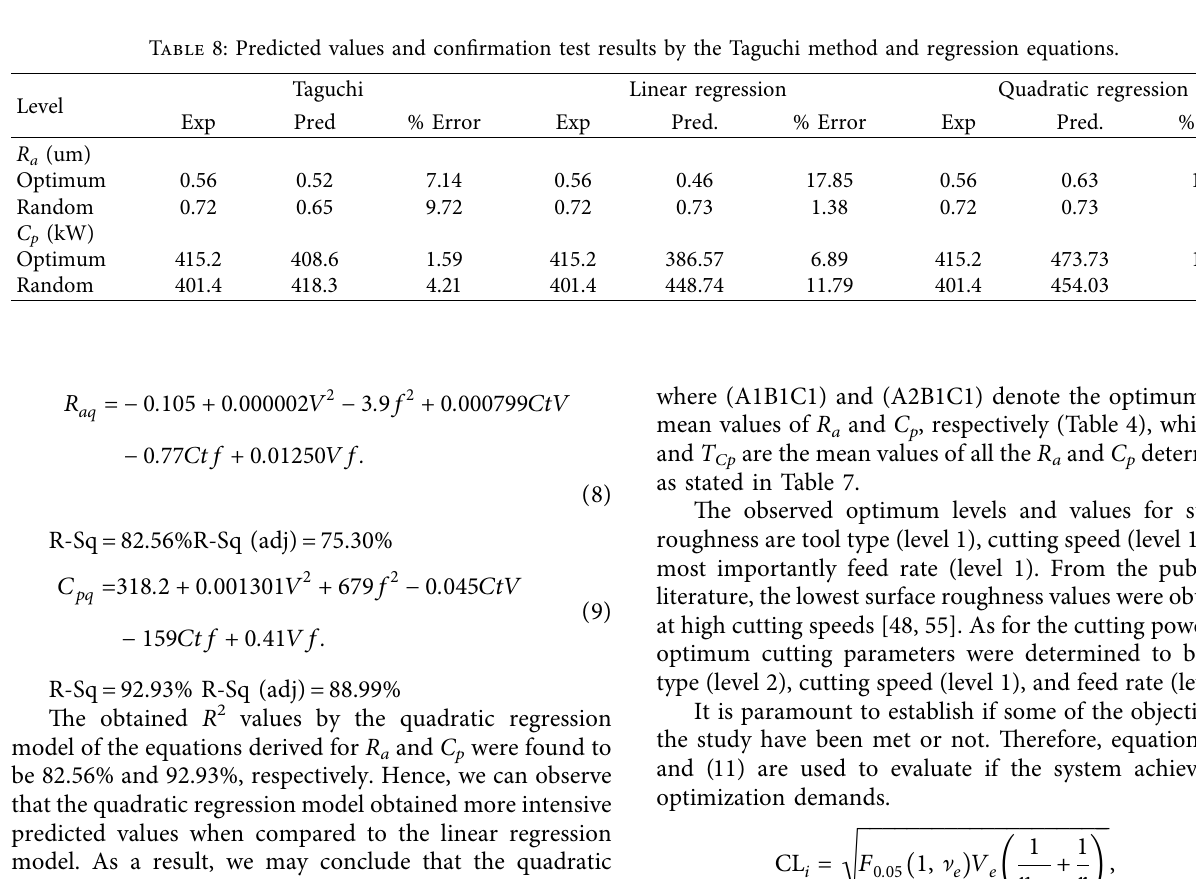
Table 7: Mean response table for R